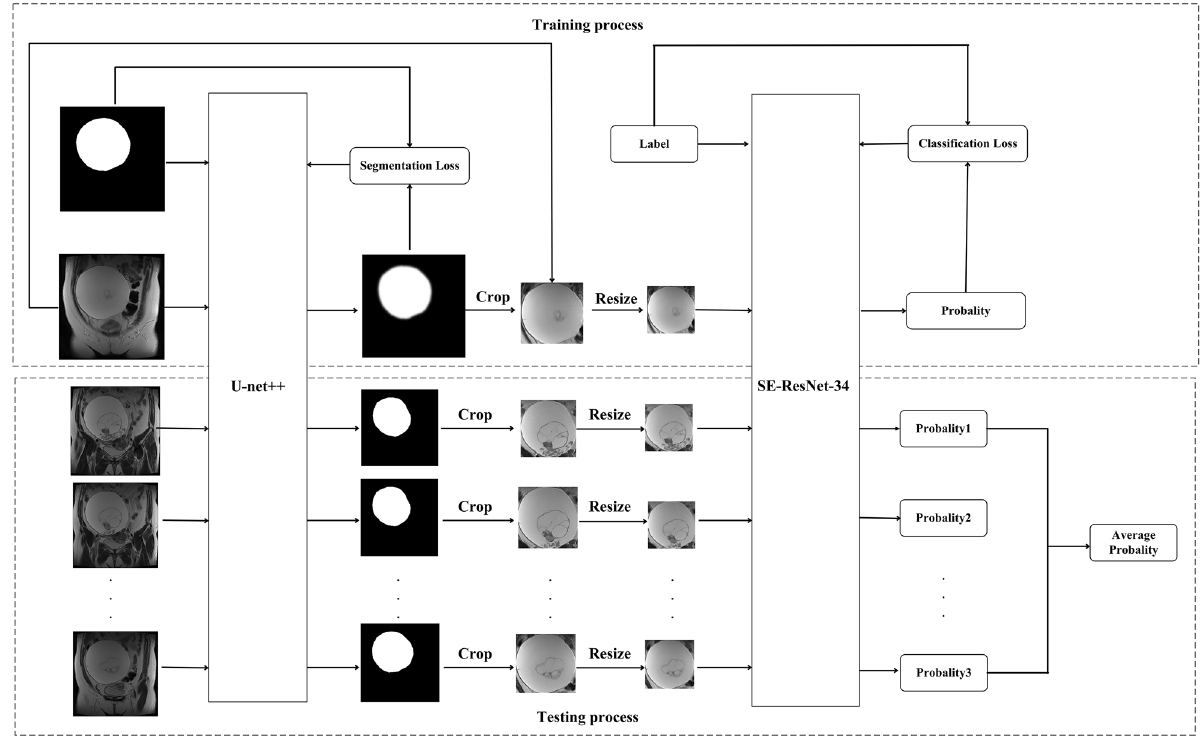
Figure 2. Flowchart of the proposed method including training and testing processes. The U-Net++ model was used to segment ovarian tumor regions in the images. Then, we cropped and resized the segmented tumor region to 96 × 96 matrix size and fed resized patch into the trained SE-ResNet-34 model to get the probability of tumor in each slice being EOC. The probability of all slices containing tumor regions was averaged to get the case-based